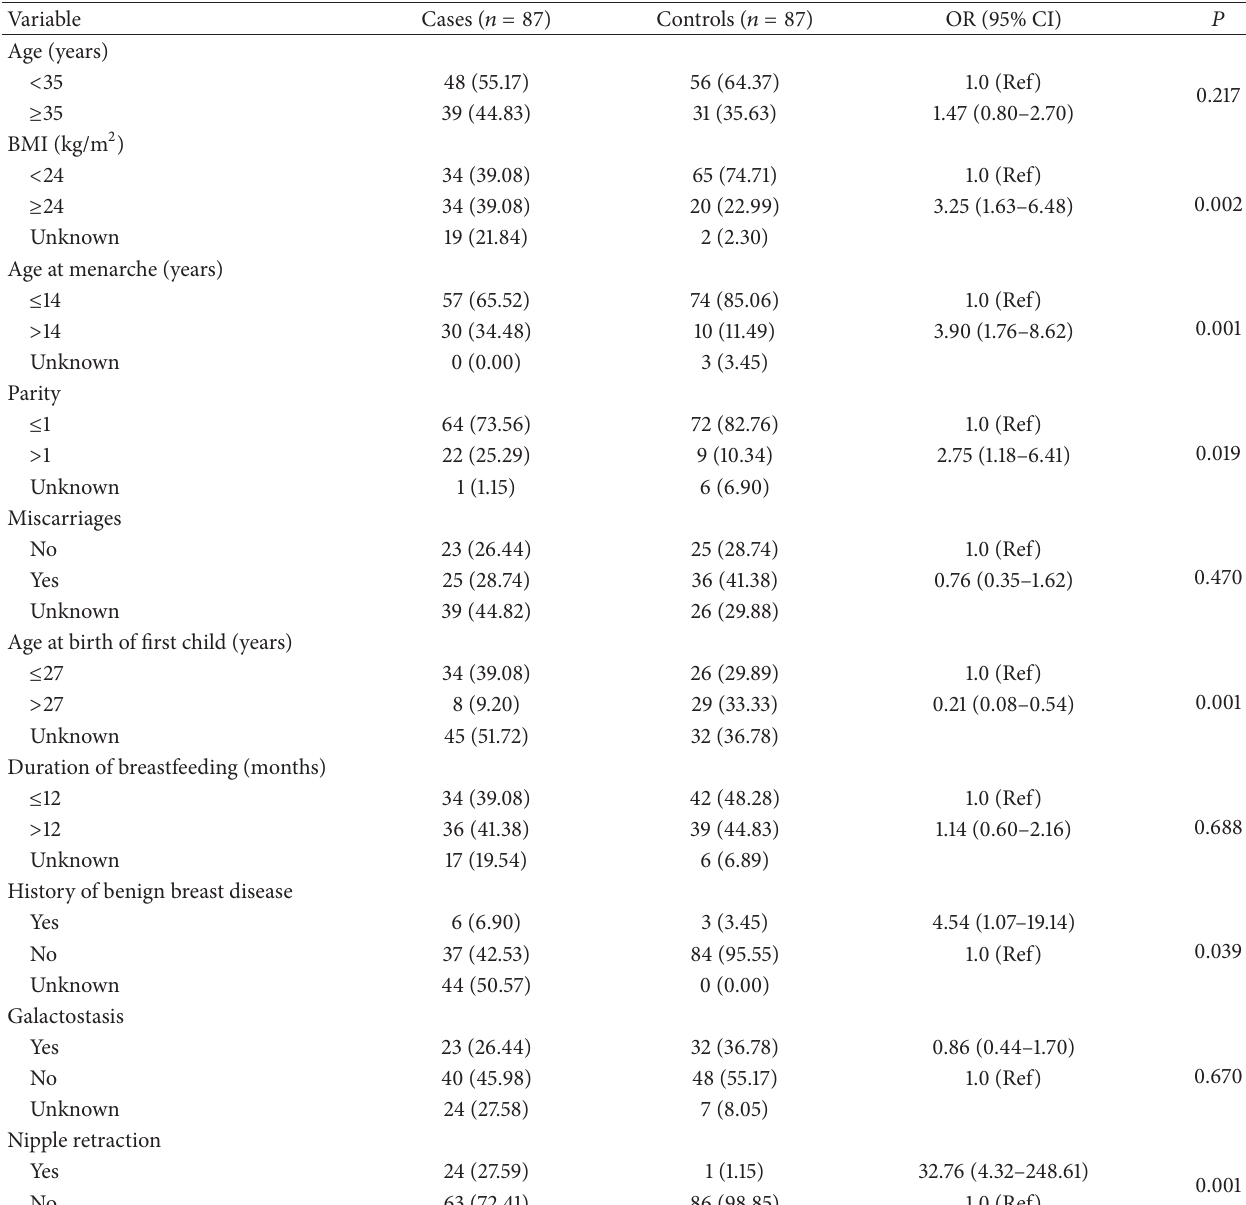
Table 3: Univariate analysis of selected risk factors for PDM ∗ .